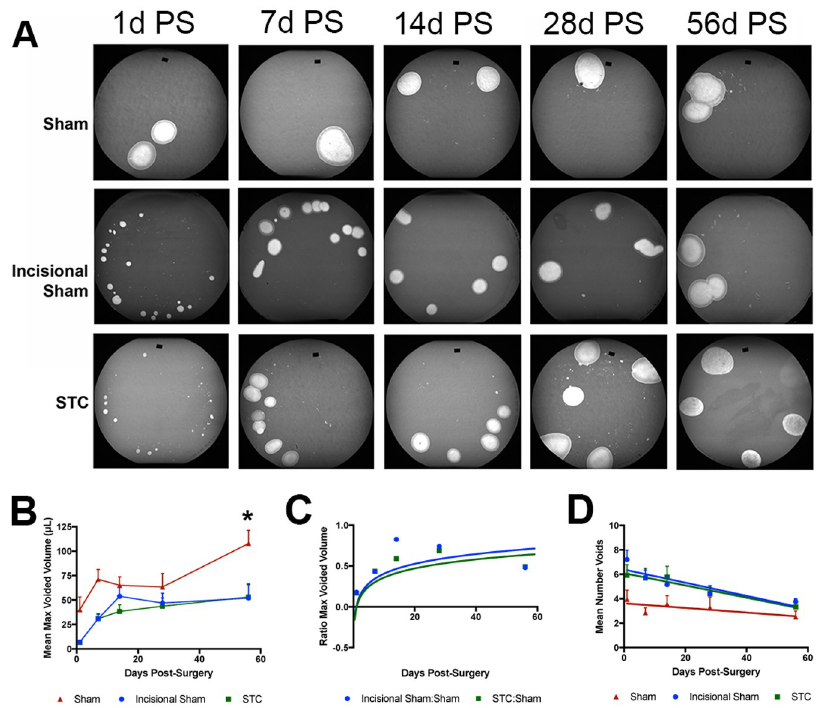
Fig 2. Recovery of voiding volume after STC. (A) Representative images of VSOP performed on sham, incisional sham and STC bladders, 1d PS, 1wk (7d PS), 2wk (14d PS), 4wk (28d PS) and 8wk (56d PS) after surgery. (B) Mean maximum voiding volume determined from VSOP analysis after determining a standard curve using mouse urine. Graph demonstrating results for maximum voided volume per void in linear incision (blue line) STC (green line) and sham (red line) bladders. The y-axis indicates mean volume in μ L and the x-axis indicates the time after surgery that mice were subjected to VSOP in days. Error bars are standard error of the mean (SEM). (C) Graph of ratio of maximum voided values in (B) for linear incision to sham (blue line) and STC to sham surgery (green line). By 56d PS the volume of STC bladders had reached 63% of age-matched sham control bladders. (D) Graph indicating the mean number of voids as indicated by spots on the blotting paper after 2h. Error bars are SEM.